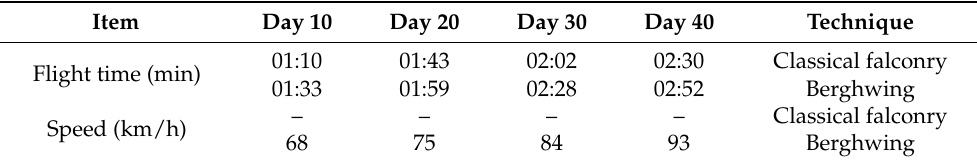
Table 4. Performances of Peregrine × Lanner falcon trained by classic or high-tech falconry. Flight time and speed (not available for manual technique) reached by the raptor and registered every ten days from the 10th to the 40th day of training.